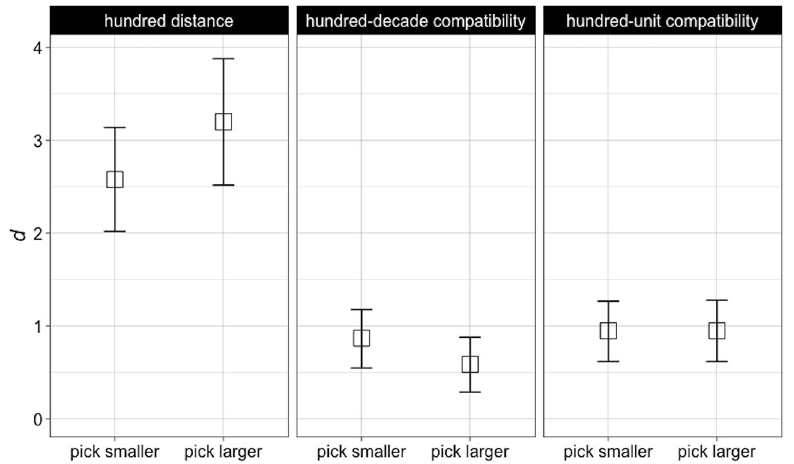
Cohen’s d and 95% Confidence Intervals Presented Separately for Each Numerical Effect and Task Instruction Bin